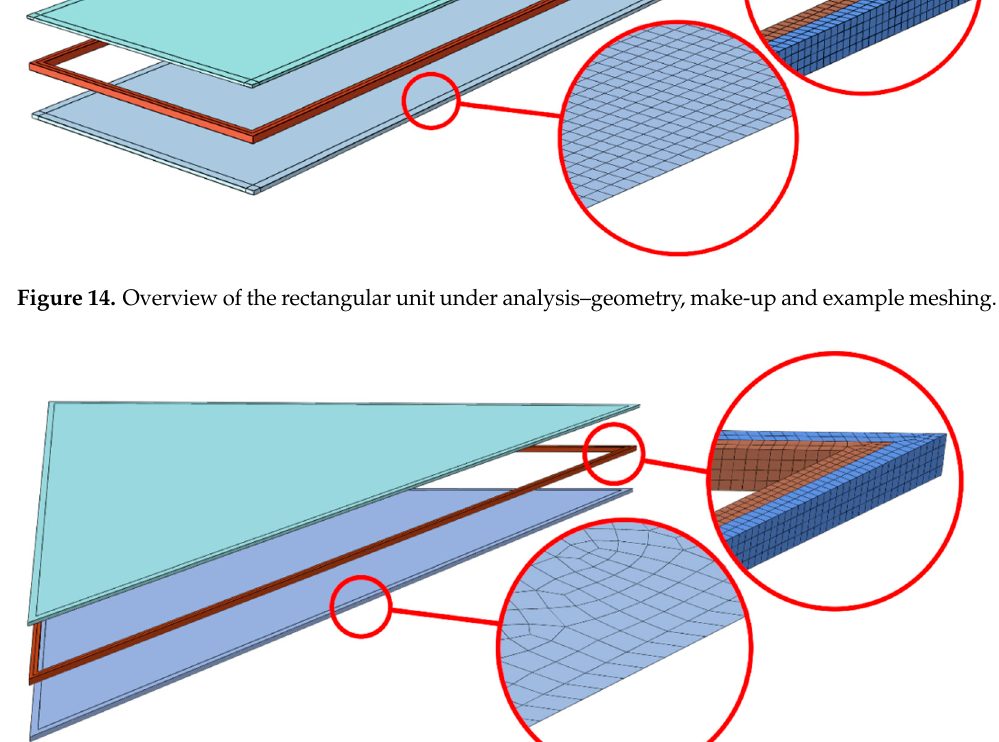
Figure 14. Overview of the rectangular unit under analysis–geometry, make-up and example mesh- ing.